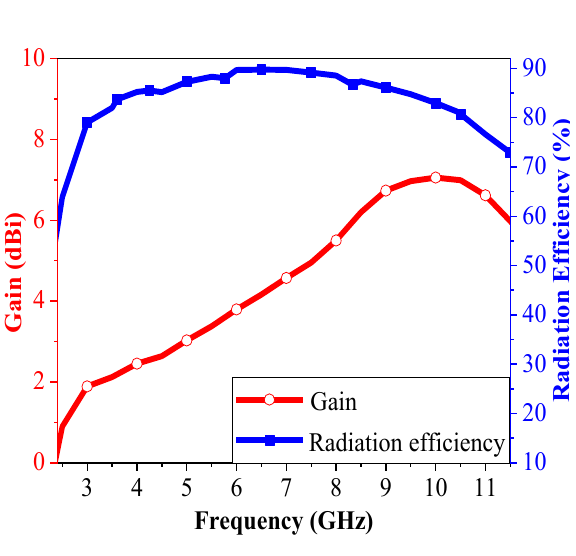
FIGURE 11. Gain and radiation efficiency achieved by the proposed antenna.